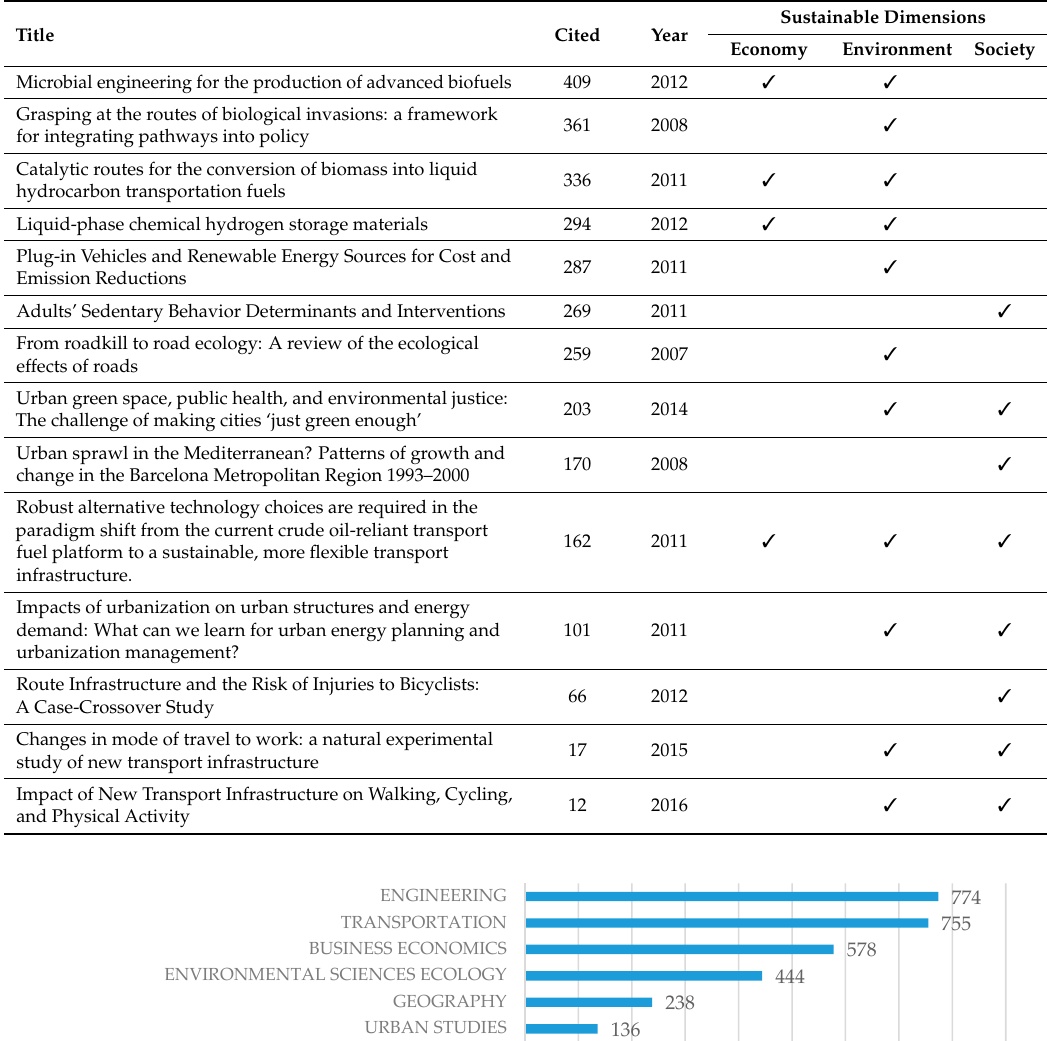
Table 1. Top highly cited research categories.